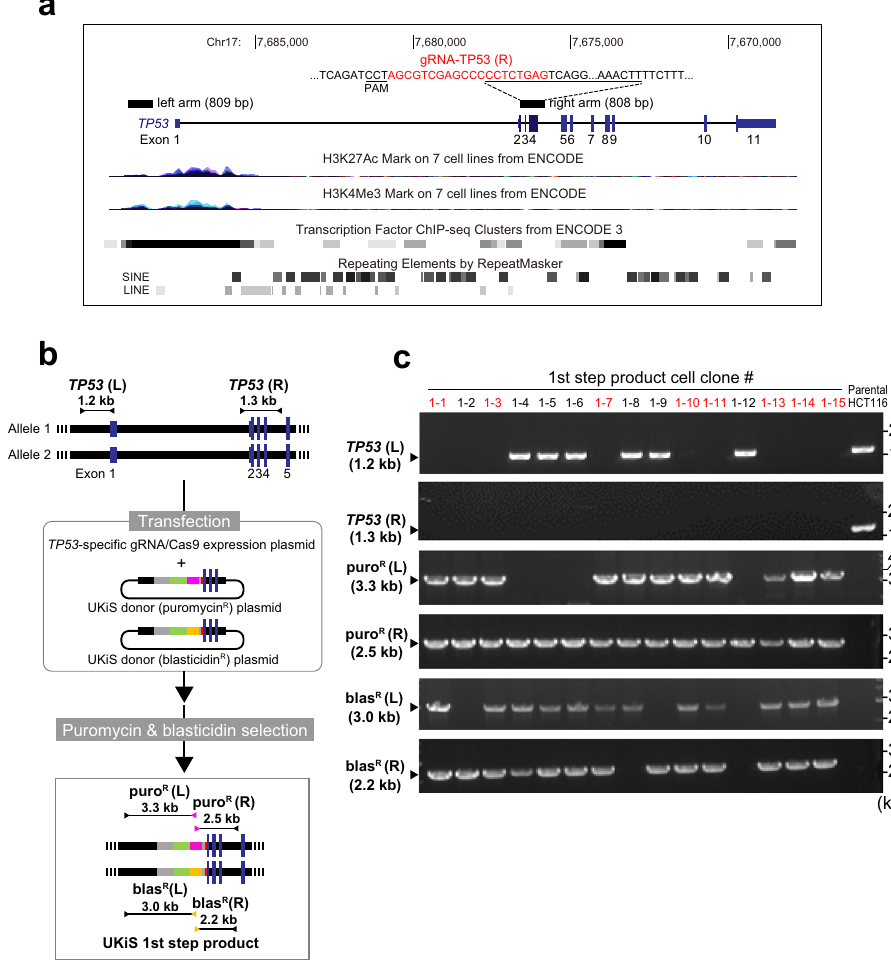
Fig. 2 The fi rst step of UKiS: replacement of the fi rst intron of TP53 with the UKiS donor. a Graphical representation of the human TP53 locus from the UCSC genome browser 41 , indicating one TP53 mRNA variant (NM_000546) and the histone activation mark (H3K27Ac and H3K4Me3), and transcription factor binding regions, all of which were identi fi ed by the ENCODE project 3 , and retrotransposon-derived elements (LINEs and SINEs are long and short interspersed nuclear elements, respectively). The regions targeted by the homologous arms of the UKiS donors are denoted by black boxes. The same arms were also used for the mutating payloads during the second step of UKiS. The gRNA-TP53(R) target sequence is highlighted in red and the PAM sequence part is underlined within the sequence of the right arm part. b Schematic diagram of the fi rst step of UKiS for the fi rst intron of TP53 . Both UKiS donor plasmids, the marker parts of which are indicated by the same colors as shown in Fig. 1b, were transfected into HCT116 cells, leading to isolation of cell clones that had undergone homologous recombination within the TP53 locus after dual selection with puromycin and blasticidin. Horizontal lines fl anked by two arrowheads represent the target regions for the junction genotyping PCR. c Representative gel image of the junction genotyping PCR to con fi rm deletion of the TP53 fi rst intron and insertion of the UKiS marker, with the expected length of PCR genotyping amplicons indicated. Of the 15 selected clones, 8 had successful replacement of the intron with the UKiS donor in both alleles and are highlighted in red. Source data are provided as a Source Data fi